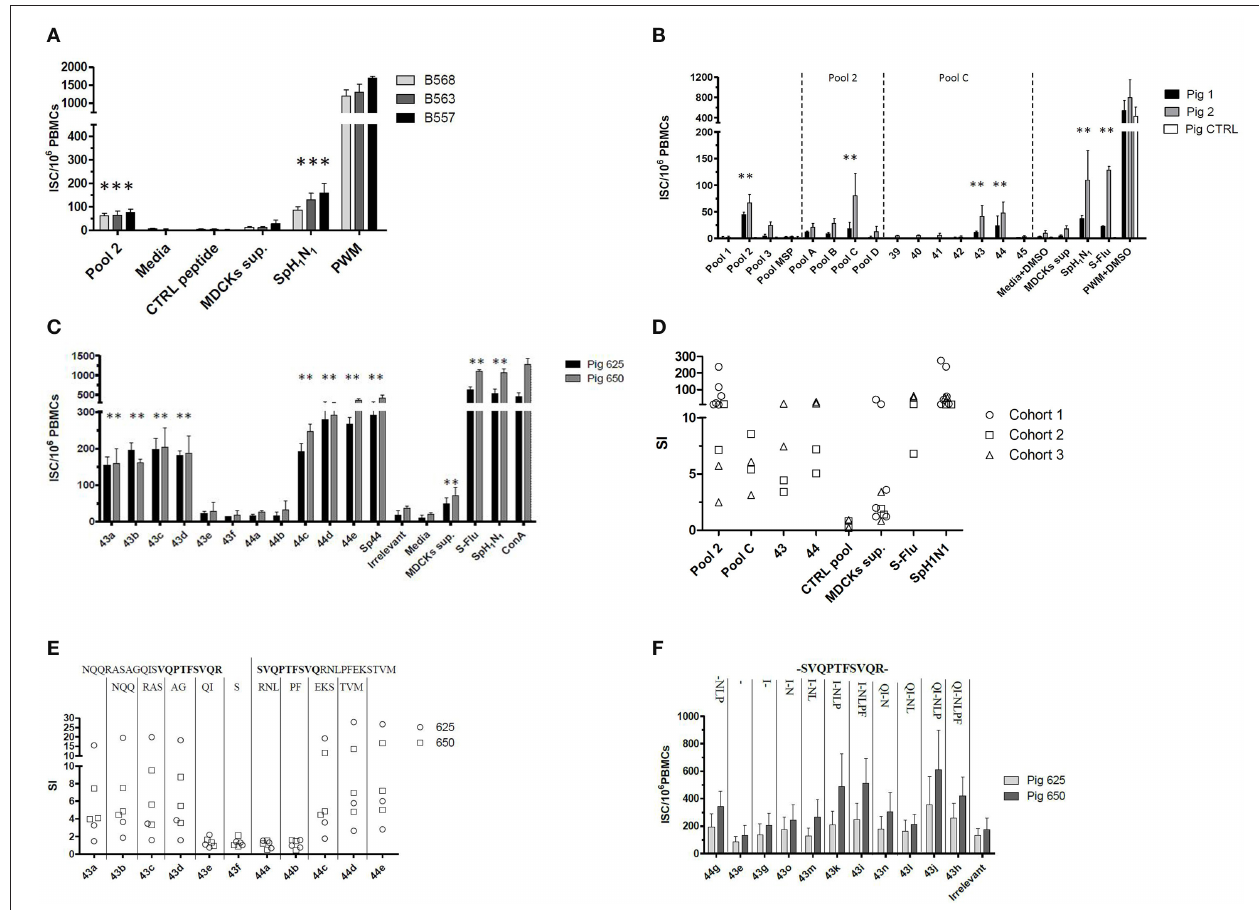
FIGURE 1 | Empirical identification of T cells epitopes. A collection of peptides spanning the NP and M1 proteins of A/Panama/2007/1999 was used to stimulate ex vivo the PBMCs collected from Babraham’s pigs. These were previously immunized using either (A) strategy 1 (i) SpH1N1 and (ii) Gripovac3 immunized pigs, (B) strategy 2 or (C,E,F) strategy 3. The recalled immune response was quantified by an IFN γ ELISPOT and calculated as number of interferon Gamma Secreting cells (ISC) per 10 6 PBMCs (A,B,F) . The results obtained throughout the tests and cohorts were transformed as Stimulation Index (SI) and summarized in (D,E) ; each dot represents the average value from a single assessment in a pig. The peptides were tested as pools (pools 1–3, pools A–D ) and individually (39–45, 43a − 44e, 44g − 43h). The letters on the top of the graph in (E) represent the amino acids sequentially deleted from peptide 43a NQQRASAGQISVQPTFSVQR or 44e SVQPTFSVQRNLPFEKSTVM. In contrast the letter on the top of the graph in (F) represent the amino acid sequentially added from the peptide 43–44 overlapping region (in bold). The UV-inactived SpH1N1 and live S-Flu (H5) IAVs were used to recall a specific immune response in the immunized pigs. The MSP pool, the irrelevant peptide, the media either supplemented or not with DMSO were used to evaluate the non-specific response of the testing system. The MDCK sup was used to evaluate the non-specific immune response against the whole virus and in particular the derived from the replication system adopted. Finally, the PWM either supplemented or not with DMSO and the ConA were used to check the responsiveness of the PBMCs used in the assay. Statistically significant differences in (A–C) are indicated by asterisk (Wilcoxon signed-rank test; p < 0.05). Figures are representative of three independent